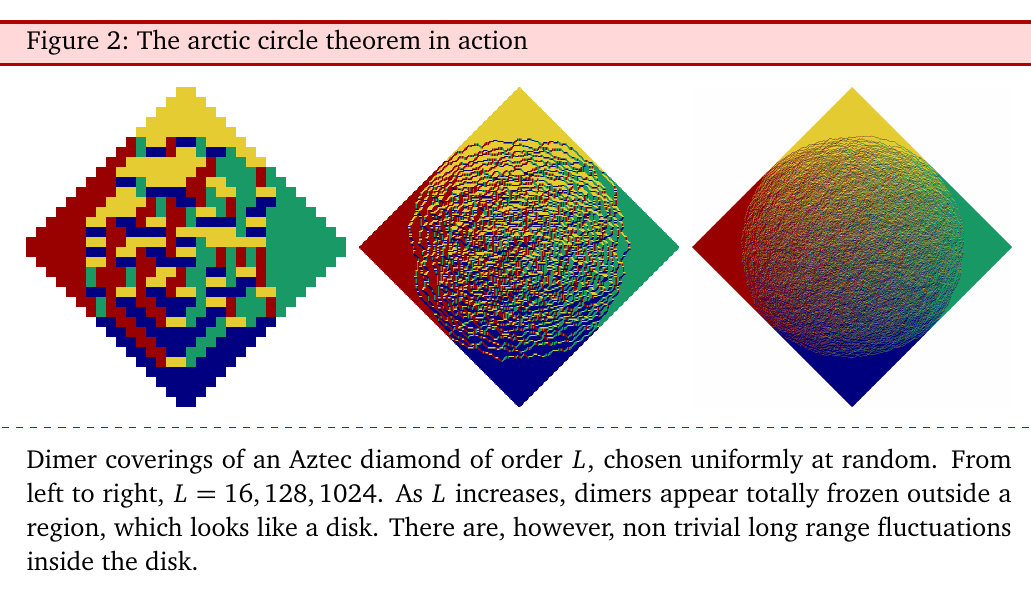
Figure 2: The arctic circle theorem in action